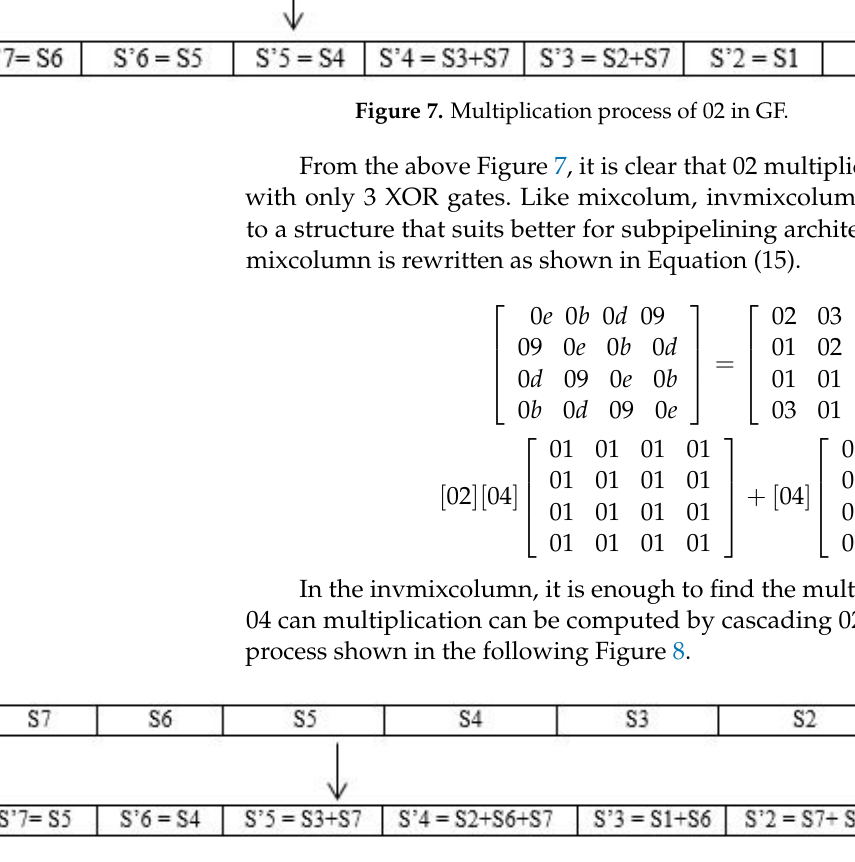
Figure 8. Multiplication process of 04 in GF.